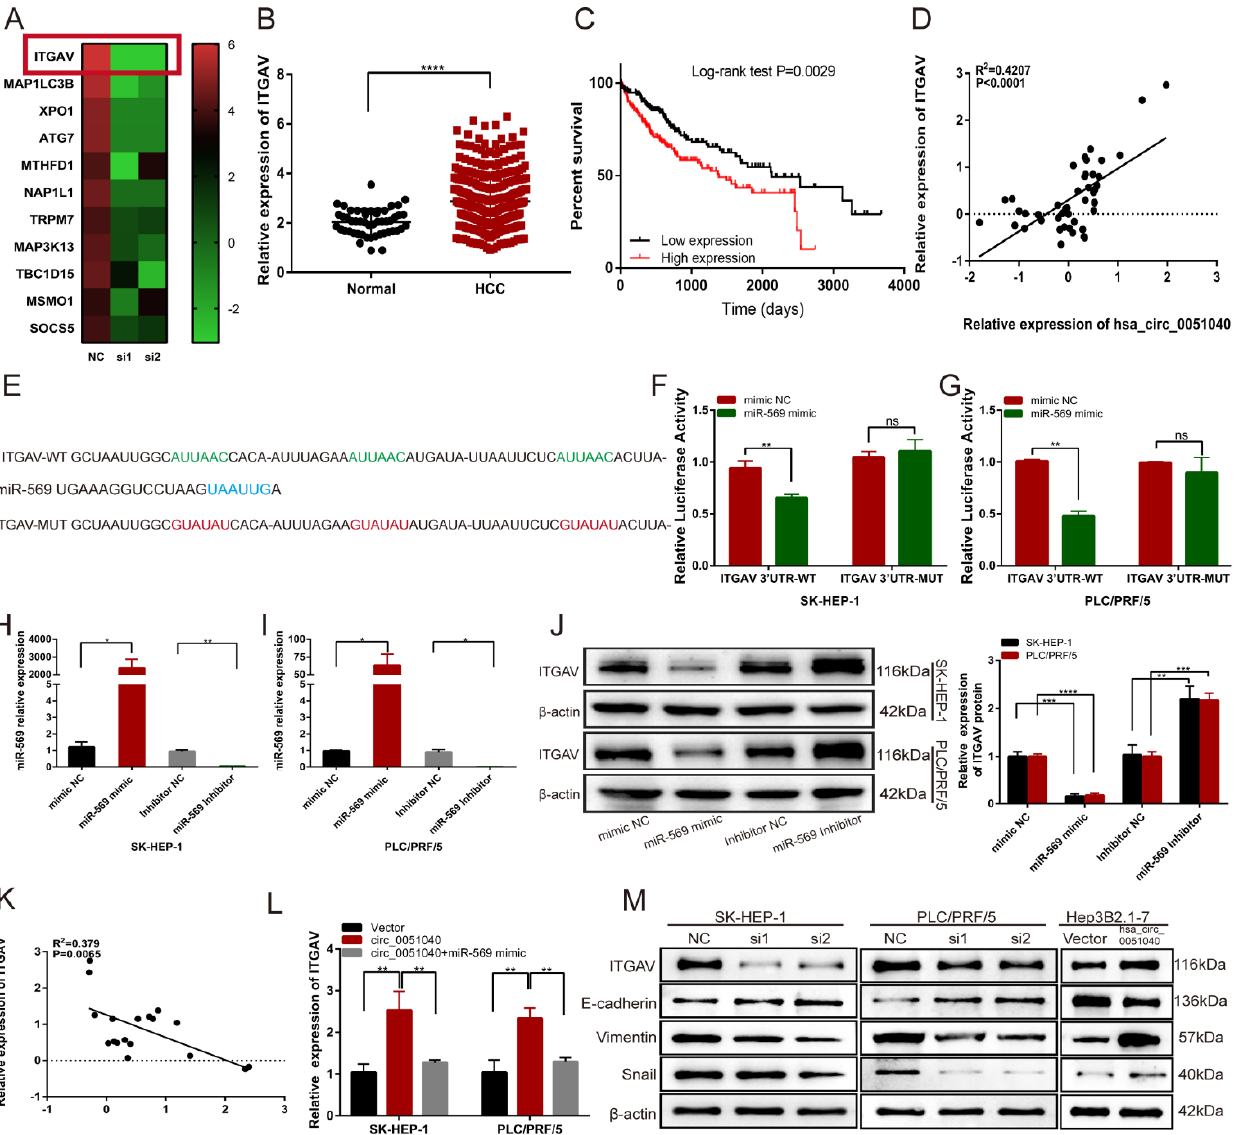
Figure 5. Hsa_circ_0051040 sponges miR-569 to upregulate ITGAV expression. ( A ) Heatmap analysis of the 11 most downregulated genes in this study. ( B ) ITGAV was upregulated in HCC according to TCGA. ( C ) Kaplan–Meier analysis indicated that patients with high ITGAV expression had low survival rates. ( D ) Correlation between hsa_circ_0051040 and ITGAV mRNA expression in HCC tissues. ( E ) Sequence alignment of binding sites between the ITGAV 3 ′ UTR and miR-569. ( F , G ) The relative luciferase activity of ITGAV 3 ′ UTR-WT or ITGAV 3 ′ UTR-MUT in the miR-569 mimic or NC group in SK-HEP-1 and PLC/PRF/5 cells. ( H , I ) qRT-PCR analysis detected miR-569 expression levels in SK-HEP-1 and PLC/PRF/5 cells transfected with the miR-569 mimic or inhibitor. ( J ) ITGAV protein expression levels in SK-HEP-1 and PLC/PRF/5 cells transfected with the miR-569 mimic or inhibitor were detected by Western blotting. ( K ) Correlation between miR-569 and ITGAV mRNA expression levels in HCC tissues. ( L ) qRT-PCR analysis showed that the relative expression of ITGAV transfected with circ_0051040 plasmids and miR-569 mimic. ( M ) Protein levels of ITGAV, E-cadherin, Vimentin, and Snail in HCC cells with knockdown or overexpression of hsa_circ_0051040 were detected by Western blotting. Statistical significance was assessed by two-tailed Student’s t test. The error bar indicates the SD. * p <0.05; ** p <0.01; *** p < 0.001; **** p <0.0001; ns, not significant.